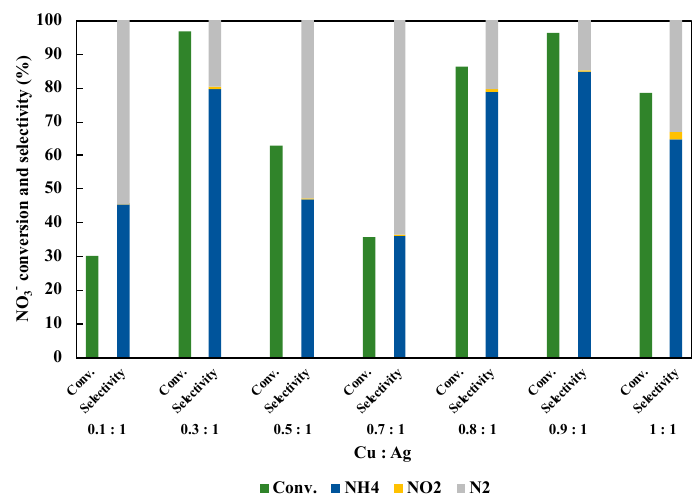
Figure 7. Effect of molar ratio of Cu and Ag loaded on TiO 2 in 45 mL of 50 ppm NO 3 − aqueous solution including 10 vol% CH 3 OH under UV irradiation for three hours. The loading amount of each samples was 30 mg.